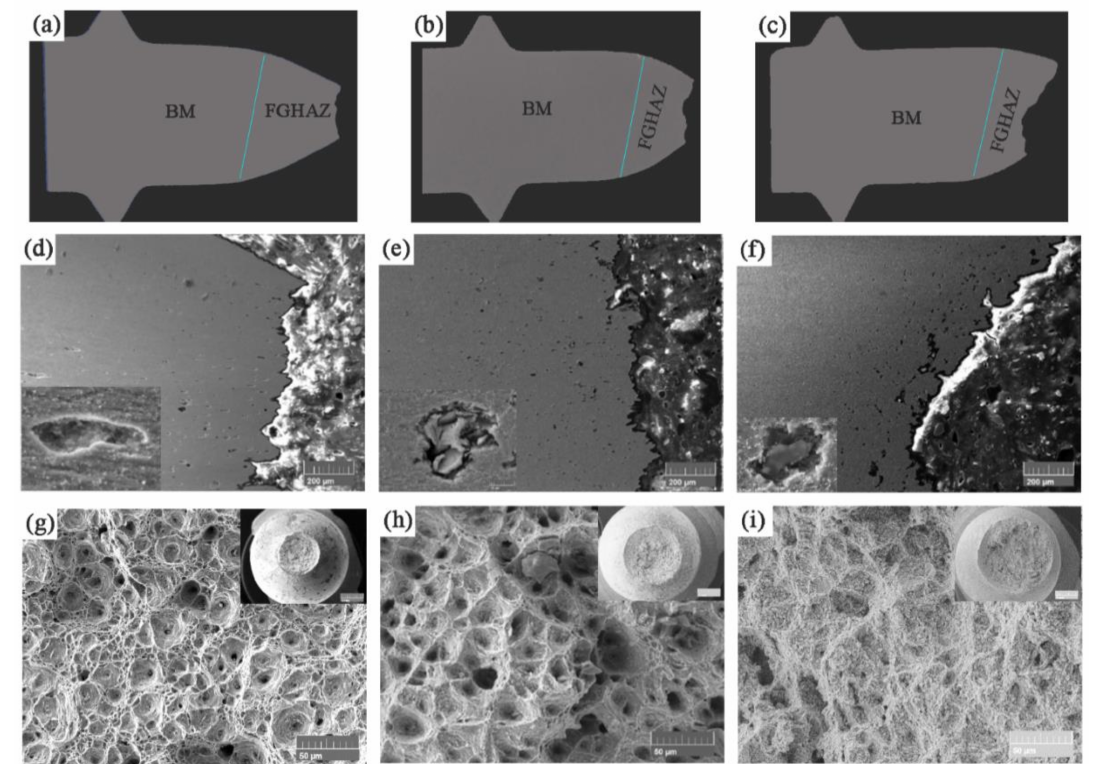
Figure 4. The microstructure of the fracture section and fracture morphology under different stresses: ( a ) 140 MPa macro section; ( b ) 120 MPa macro section; ( c ) 100 MPa macro section; ( d ) 140 MPa micro section; ( e ) 120 MPa micro section; ( f ) 100 MPa micro section; ( g ) 140 MPa fracture morphology; ( h ) 120 MPa fracture morphology; ( i ) 100 MPa fracture morphology.